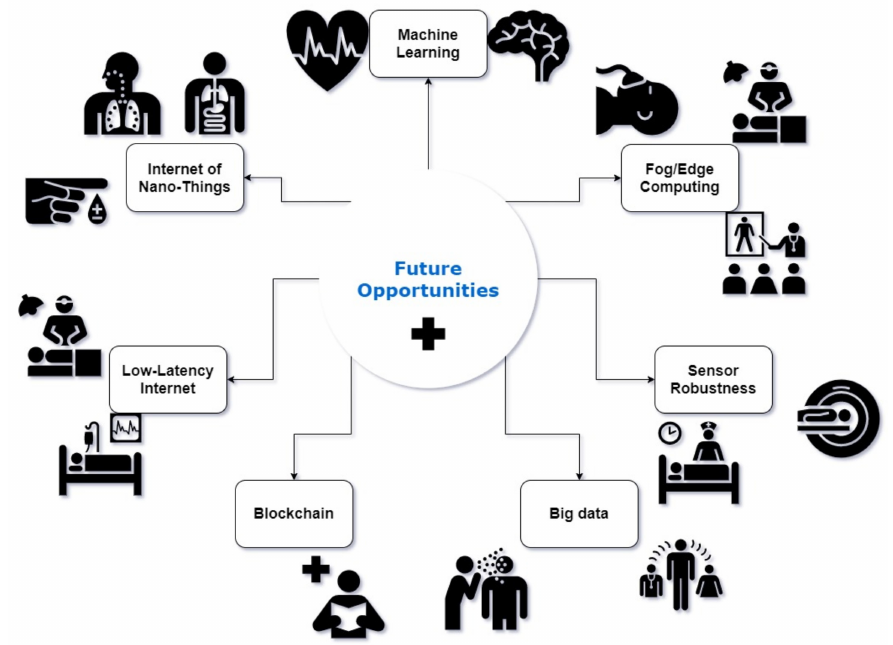
Figure 14. Future opportunities—IoT-assisted wearable sensor systems in